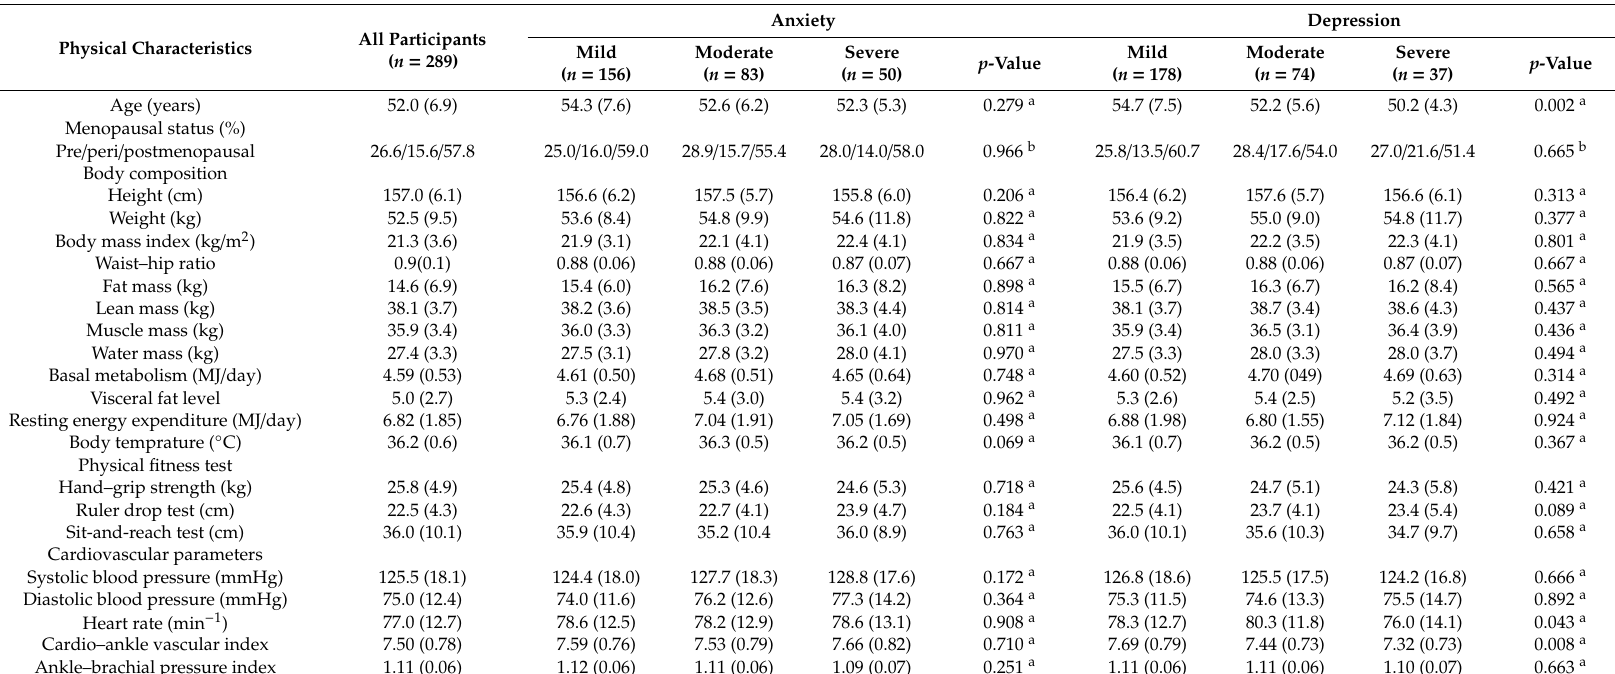
Table 1. The physical characteristics of all participants and comparison of these factors between women with mild, moderate, and severe anxiety and depressive